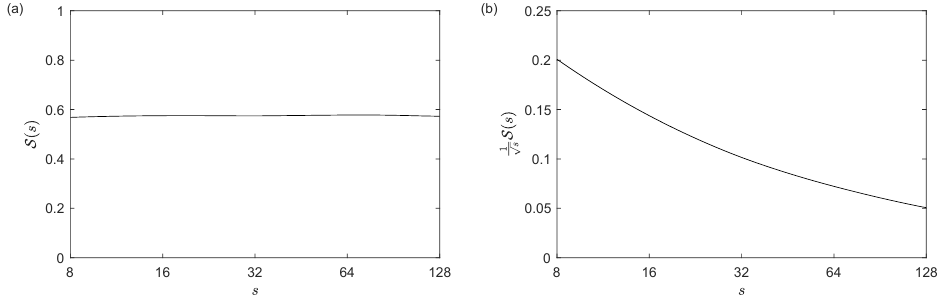
Figure 3. ( a ) Mean of the scalograms of 100 random uniform series in [ − 1,1 ] of 10,000 data points, using Morlet wavelet. It can be seen that it is more or less constant and so, the corresponding scale index would be close to 1 for any s 1 . ( b ) Mean of the 100 scalograms of the same random uniform series but multiplied by the factor 1 √ . It tends to zero for large scales and so, the scale index computed s from this modified scalogram would also tend to zero as we increase s 1